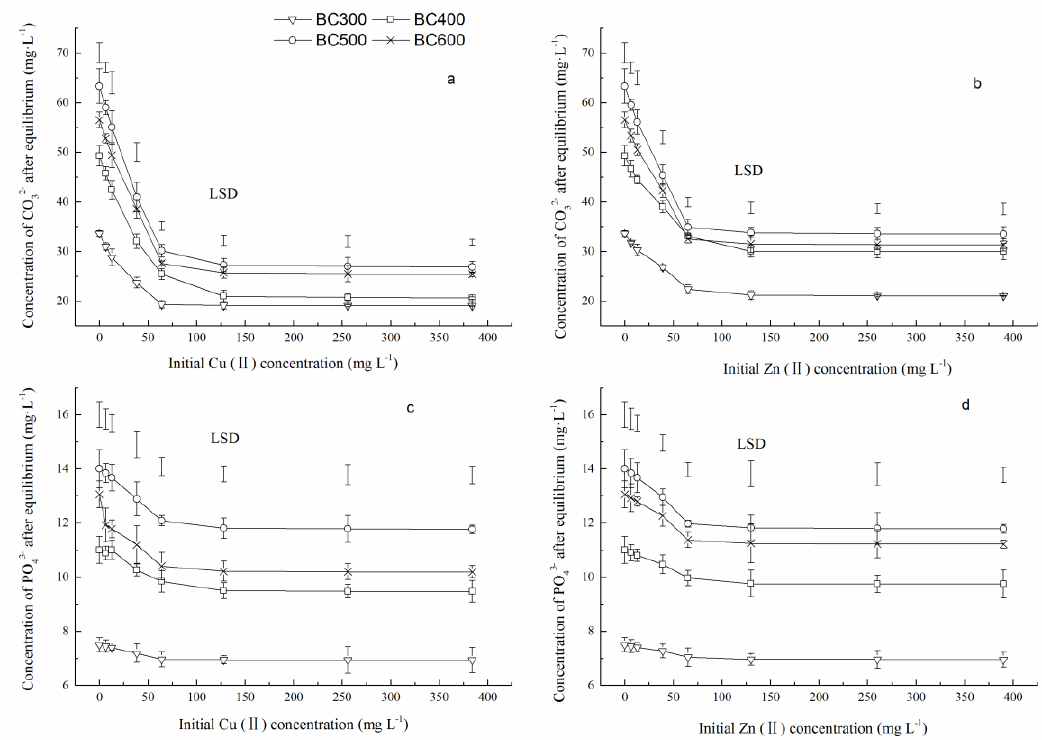
Figure 7. Effect of initial heavy metal concentration on the percent removal of the Cu(II) ( a ) and Zn(II) ( b ) (reaction temperature 25 °C; BC dosage 5 g·L −1 ; initial solution pH 5.0; contact time 1440 min). Error bars represent standard error ( n = 3). LSD is the least significant difference at p < 0.05 under the same initial heavy metal concentration.